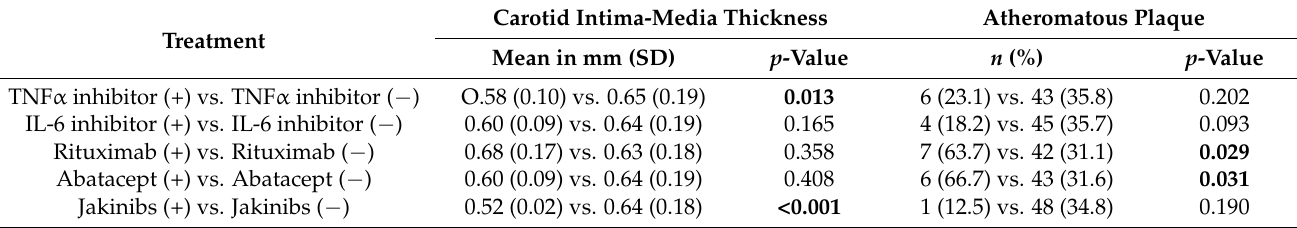
Table 2. Relationship between carotid ultrasound findings and various therapies studied (biologics and targeted synthetic disease-modifying antirheumatic drugs).